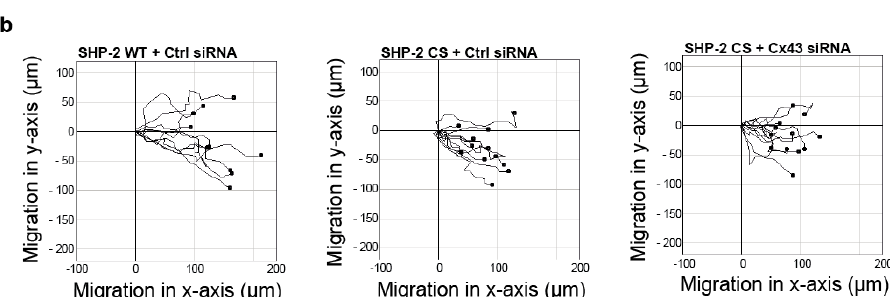
Figure 4. Inactivation of SHP-2 reduces endothelial cell migration. ( a ) Overexpression of a dominant negative substrate trapping mutant SHP-2 (SHP-2 CS) in HMEC significantly reduced serum (10%) induced endothelial cell migration, as assessed by the accumulated distance in µm in an in vitro wound assay (* p < 0.05, n = 3 independent cell cultures) compared to SHP-2 WT. Additional knock- down of Cx43 (Cx43 siRNA) did not further decrease migration (ns: not significant, n = 3 independent cell cultures). ( b ) Representative single cell traces of migrated HMEC.